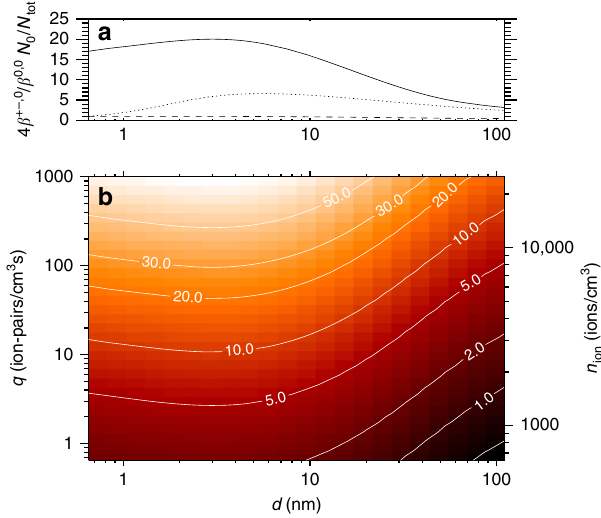
Fig. 1 Calculation of ion contribution to growth. a The average relative electrostatic enhancement 4( β ± 0 / β 00 )( N 0 / N tot ) between ions and aerosols of diameter d (solid line). The dotted line is ( β ± 0 / β 00 ), and the dashed line is ( N 0 / N tot ). b The relative size of the ion condensation, Γ (Eq. (6)) in %, in an atmosphere with a condensible gas concentration of 1 × 10 6 molecules cm − 3 as a function of aerosol diameter d and ionization rate q (left hand axis) or ion density (right hand axis). The contour lines show the relative size of the growth due to ion condensation in % of the usual condensation growth. The mass ratio ( m ion / m 0 ) is set to 2.25, and the mass of the neutral molecule is set to 100